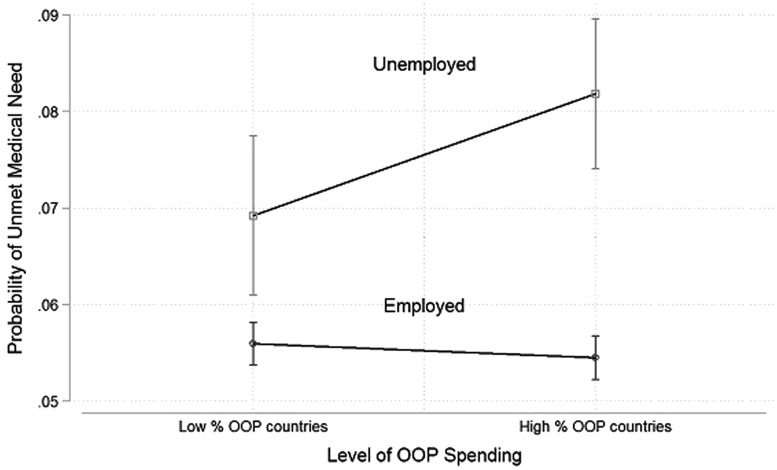
Predicted probabilities of UMN according to OOP type. Notes: Vertical lines are 95% confidence intervals.